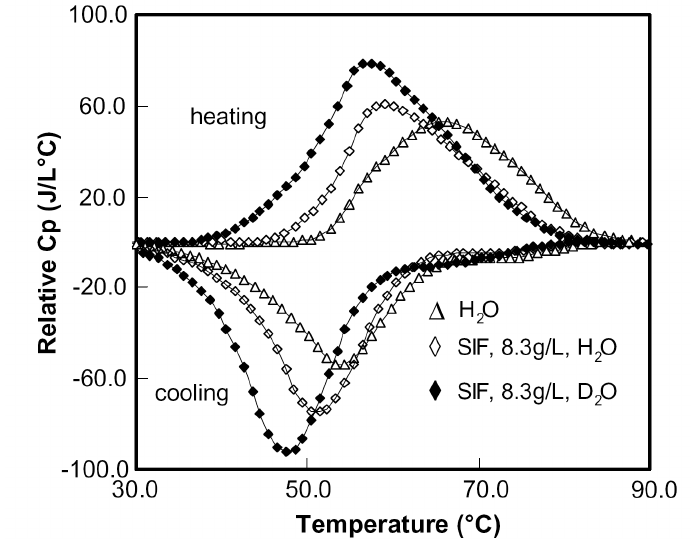
Figure 15. Thermal behavior of HPMC (10 wt%) in various